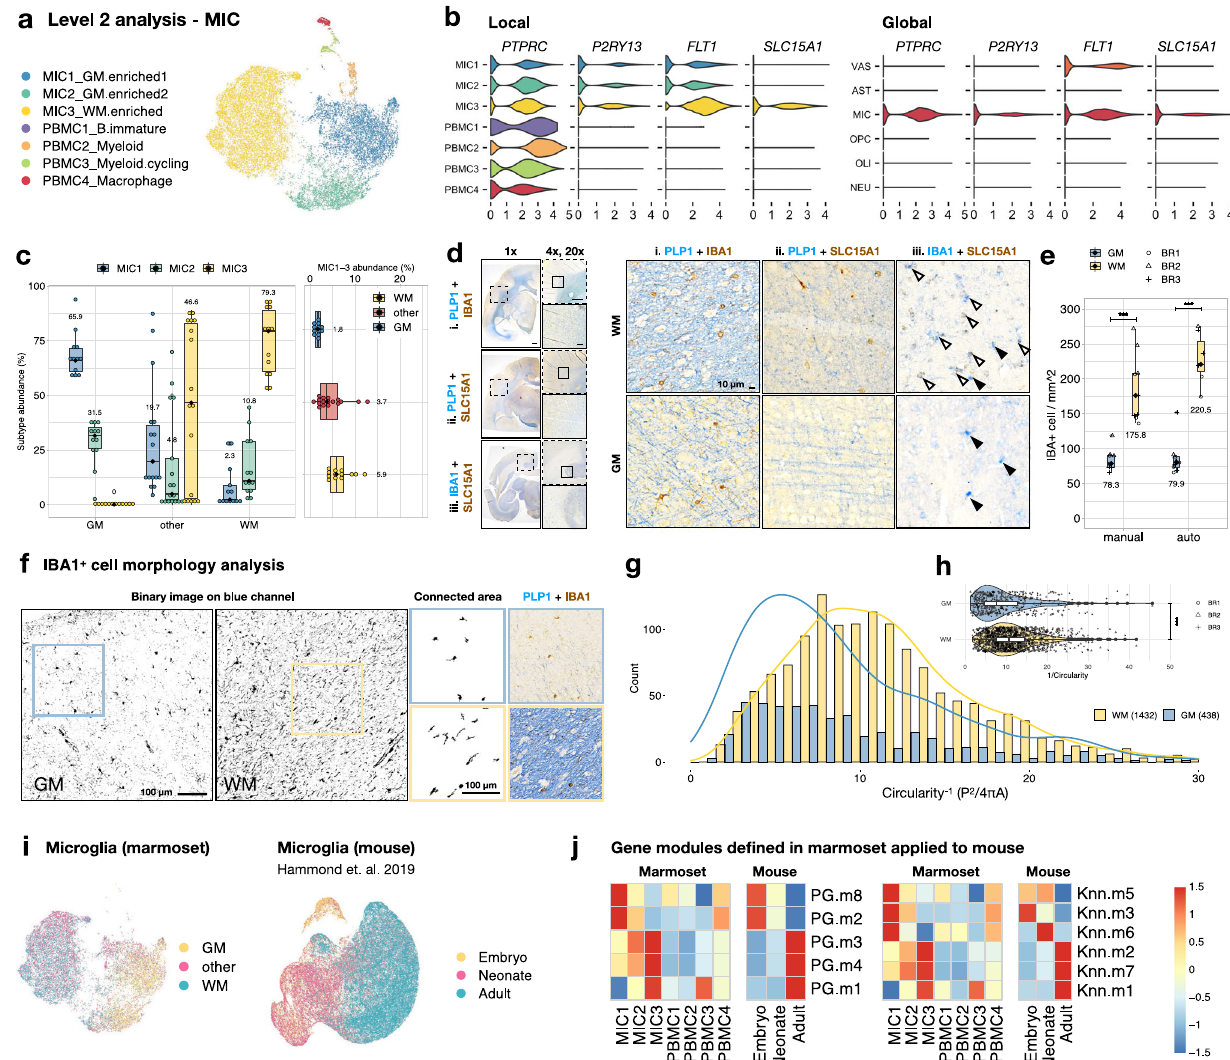
Fig. 3 | WM-microglia appear more advanced in age than GM-microglia, are elongated, and selectively express SLC15A1. a UMAP plot of microglia/immune cells colored by Level 2 subclustering. PBMC peripheral blood mononuclear cells. b Violinplotshowingtheexpressionofgenesineachsubcluster(local)andineach cell class (global). c Relative abundance of microglia by coarse tissue category; n =42 independent samples; the median is annotated (black diamond shape) and listed. d ExpressionofSLC15A1inadultmarmosetbrainsections.Solidarrowheads, IBA1 + /SLC15A1 − microglia; open arrowheads, IBA1 + /SLC15A + microglia. IBA1 is a pan microglia marker, and intense PLP1 labeling demarcates the WM area. Scale bar, 1mm (1x and 4x), 100 μ m (20x). e Box-and-whisker plot showing the number of IBA1 + cells from three ROI per tissue type per biological repeat (BR) that